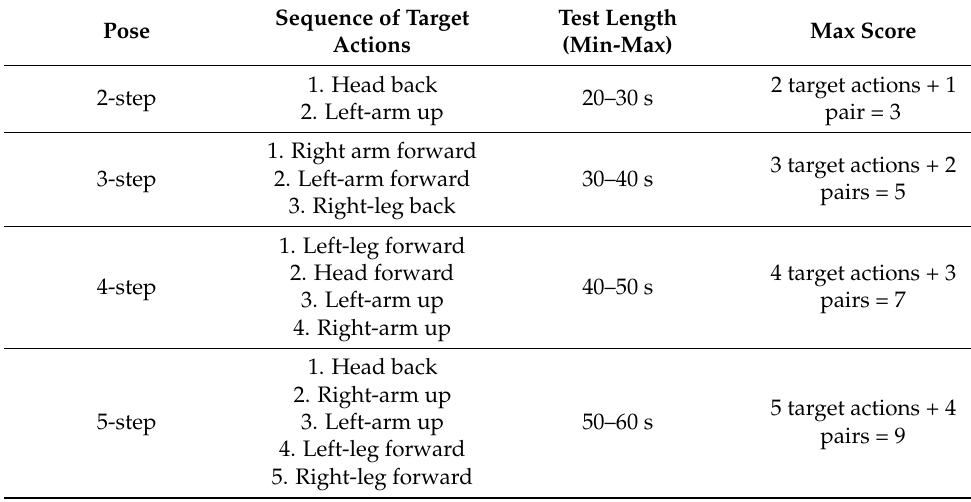
Table 1. The 2- to 5-step sequences